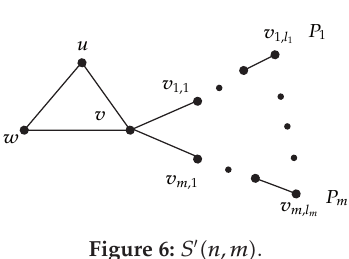
Figure 6: S (cid:10) (cid:3) n,m (cid:4)